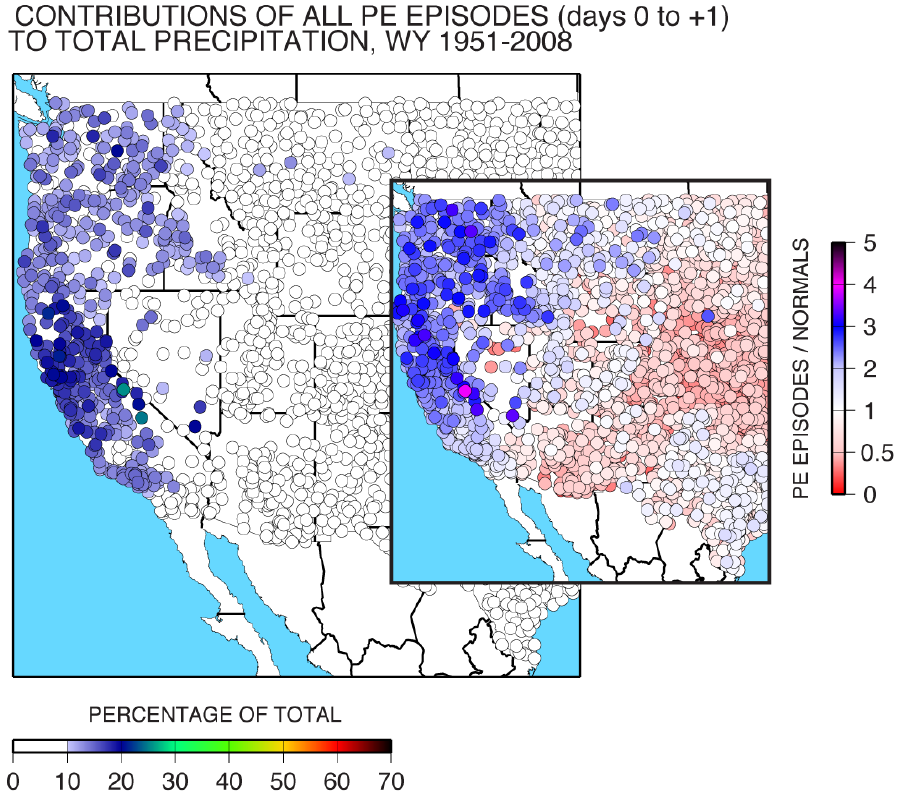
Figure 7. Same as Figure 6, except for PE days from water year 1951–2008, based on Table 2.